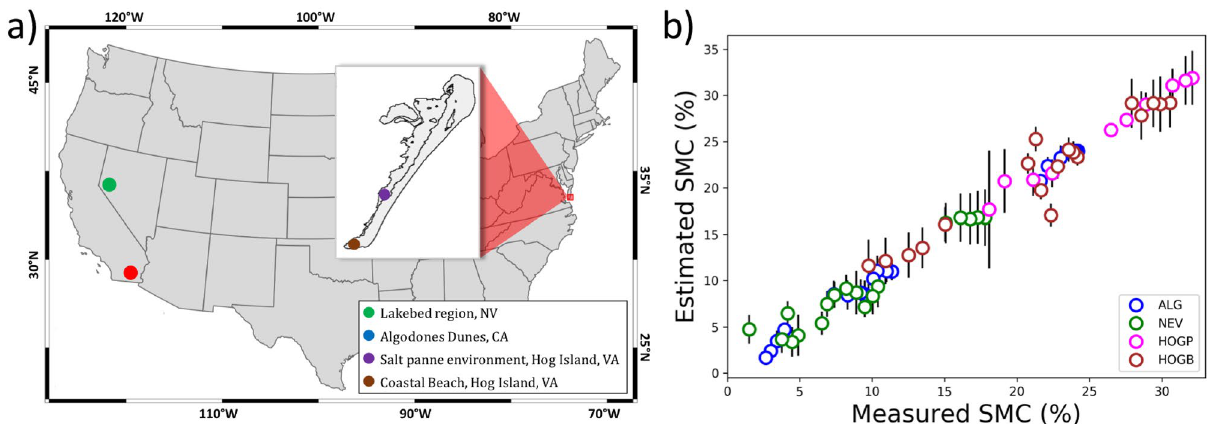
Figure 2. ( b ) Relationship between the estimated model SMC and measured SMC for laboratory samples from the four field test sites: ( a ) Algodones (ALG), Nevada (NEV), Hog Island Panne (HOGP), and Hog Island Beach (HOGB). ( b ) Circles represent the best matched moisture obtained across all sensor zenith and azimuth measurements and wavelength combinations, while y-error bars represent the variation of the SMC output by the model at a specific wavelength over the spectral reflectance recorded by GRIT-T over all zenith and azimuth